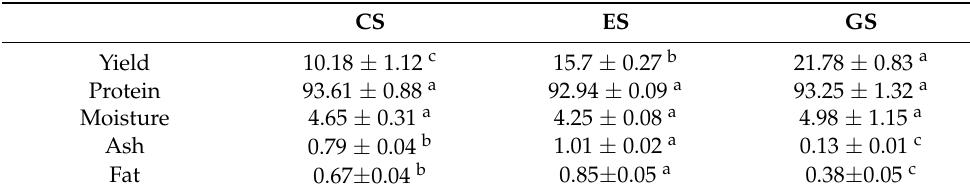
Table 1. Yield and basic components of fish